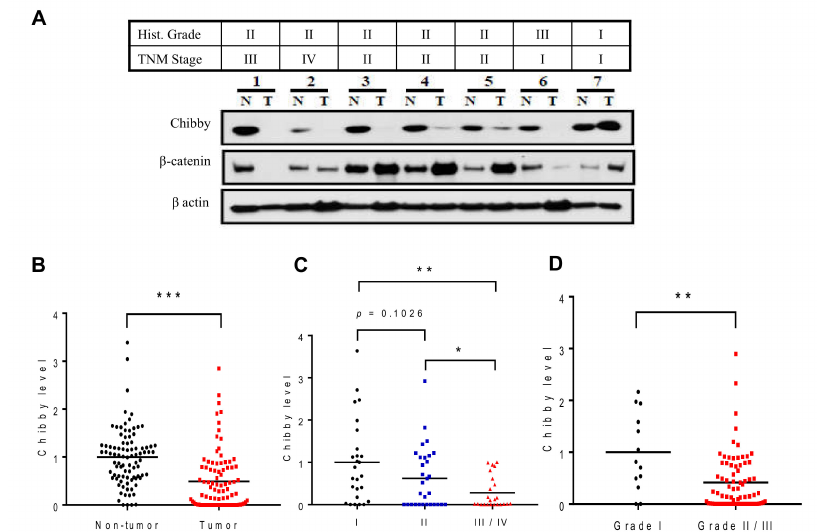
Figure 1. Chibby is downexpressed in hepatocellular carcinoma (HCC) and correlated with advanced stage. ( A ) The Western blotting (WB) analyses of Chibby and β -catenin protein expression in seven pairs of HCC tissues (T) and their paired non-tumor tissues (N). Patient 1 was histology grade I and TNM stage III; patient 2 was histology grade II and TNM stage IV; patient 3-5 were histology grade II and TNM stage II; patient 6 was histology grade III and TNM stage I; patient 7 was histology grade I and TNM stage I. β -actin was used as a loading control. Chibby protein levels were significantly lower in HCC tumors ( B ), high TNM stage ( C ), and high histology grade ( D ). * p < 0.05; ** p < 0.01; *** p < 0.005.